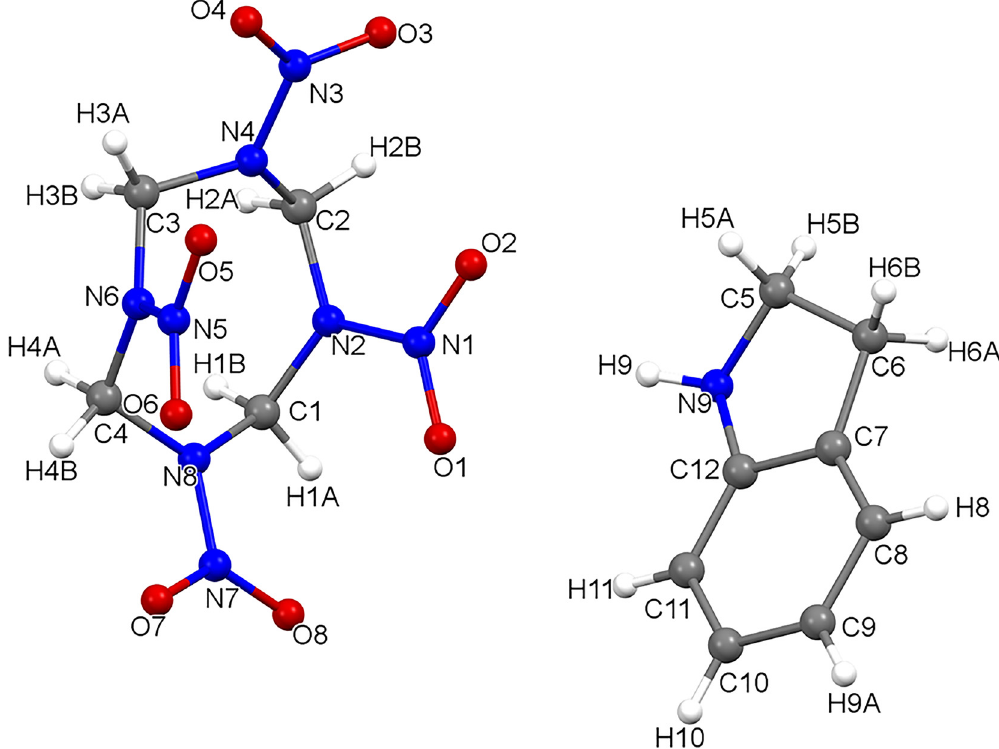
Table 1 contains crystallographic data and Table 2 contains the list of the atoms including atomic coordinates and displacement parameters.